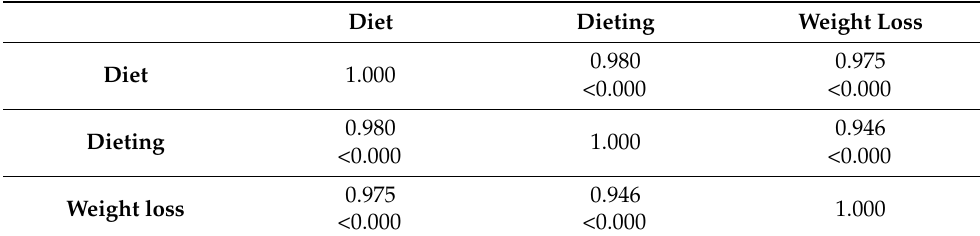
Table 1. Associations between search terms diet, dieting, and weight loss. Diet Dieting Weight Loss Diet 1.000 Dieting Weight loss